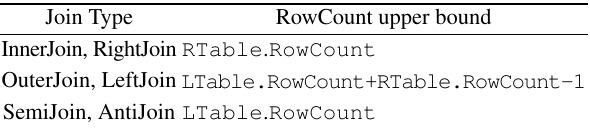
Table 2 RowCount estimation for